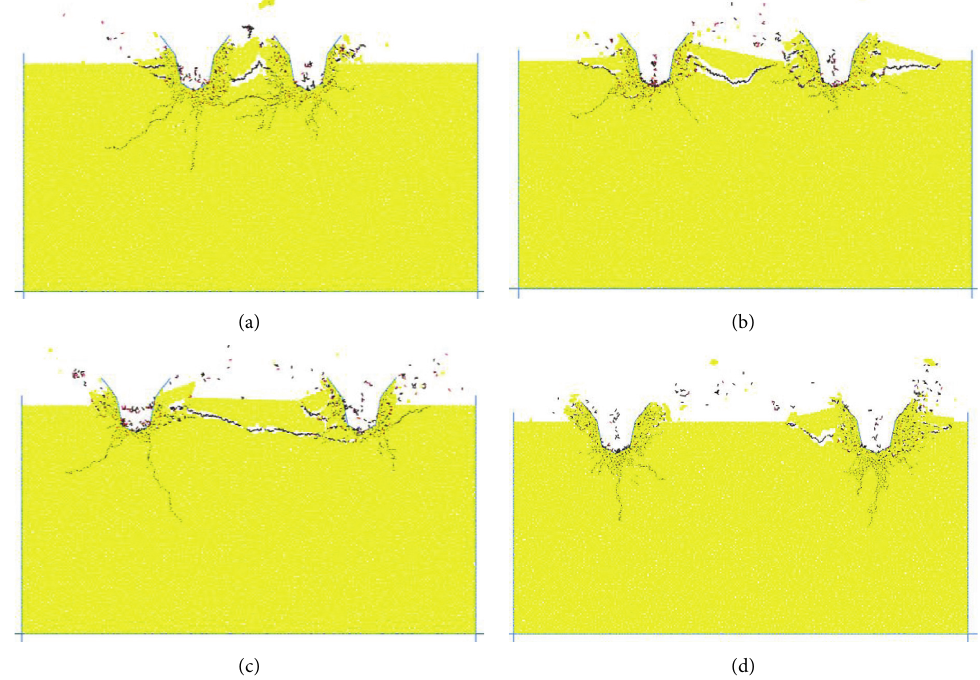
Figure 9: Crack propagation under different disc cutter spacing: (a) 60.0mm, (b) 80.0 mm, (c) 100.0 mm, and (d) 120.0mm.